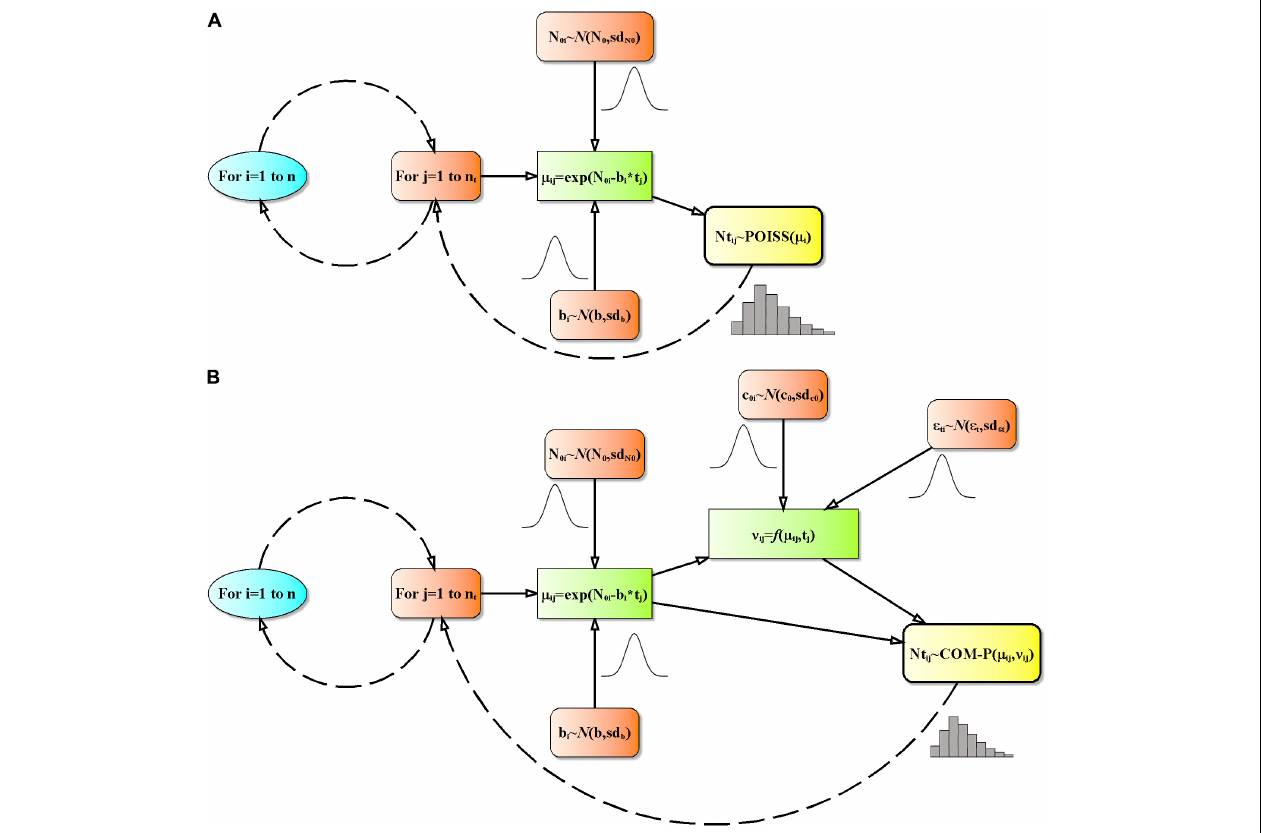
FIGURE 1 | Flowcharts of the computer modeling in the Poisson (A) and in the COM-Poisson process (down) (B) . Prediction was by Monte Carlo simulation. n: number of simulations; t j , time; n t , number of experimental times; N 0 i : realization of initial count characterized by a normal distribution with mean N 0 and standard deviation sd N 0 ; b i , realization of survival rate characterized by a normal distribution with mean b and standard deviation sd b ; µ ij , centering parameter of the Poisson or COM-Poisson distribution; N tj , realization of µ ij , i.e., the number of survivors; POISS(): Poisson distributed random numbers; ν ij , COM-Poisson dispersion parameter; CMP(): COM-Poisson distributed random numbers; c 0 i , realization of the non-randomness variance parameter characterized by a normal distribution with mean c 0 and standard deviation sd c 0 ; ε tij , realization of the additional non-randomness variance parameter characterized by a normal distribution with mean ε t and standard deviation sd ε t